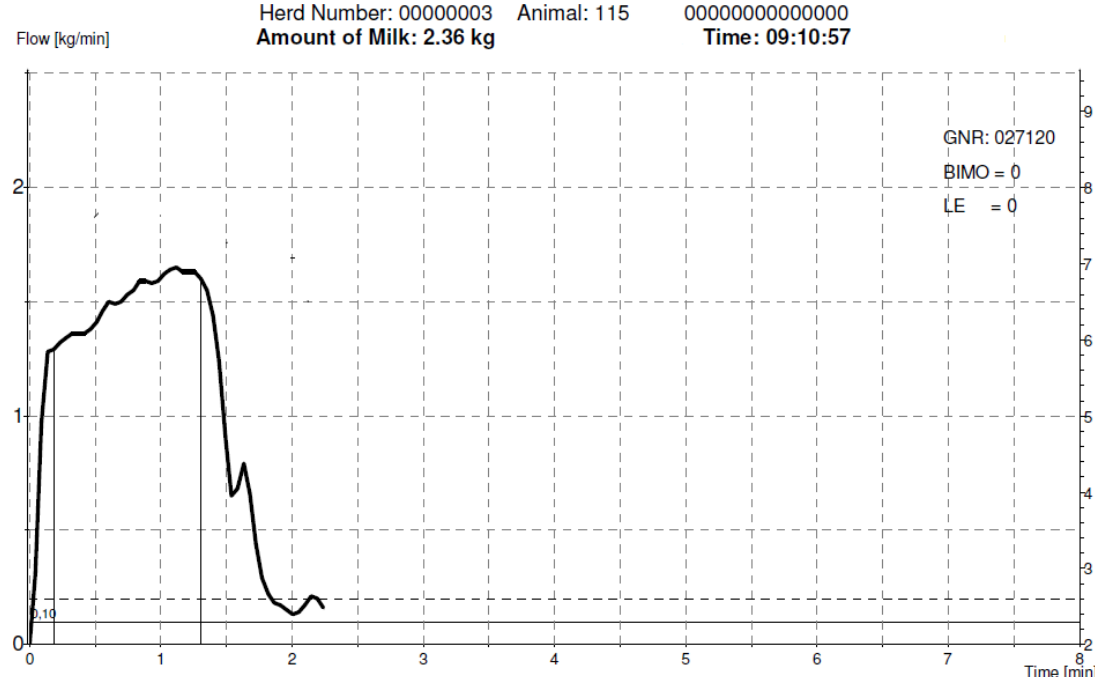
Figure 2. Milk emission curve recorded by the Lactocorder device to show the emission curve that characterizes other European breeds (high average milk flow).